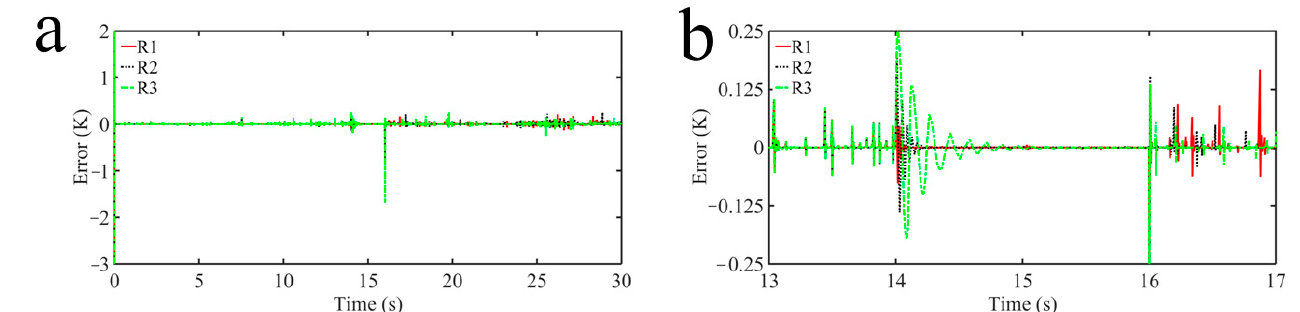
Figure 25. Simulation results with some external disturbances: ( a ) the tracking errors of Wall 0_3 mm for composite controller; ( b ) their partial enlarged figures in details.